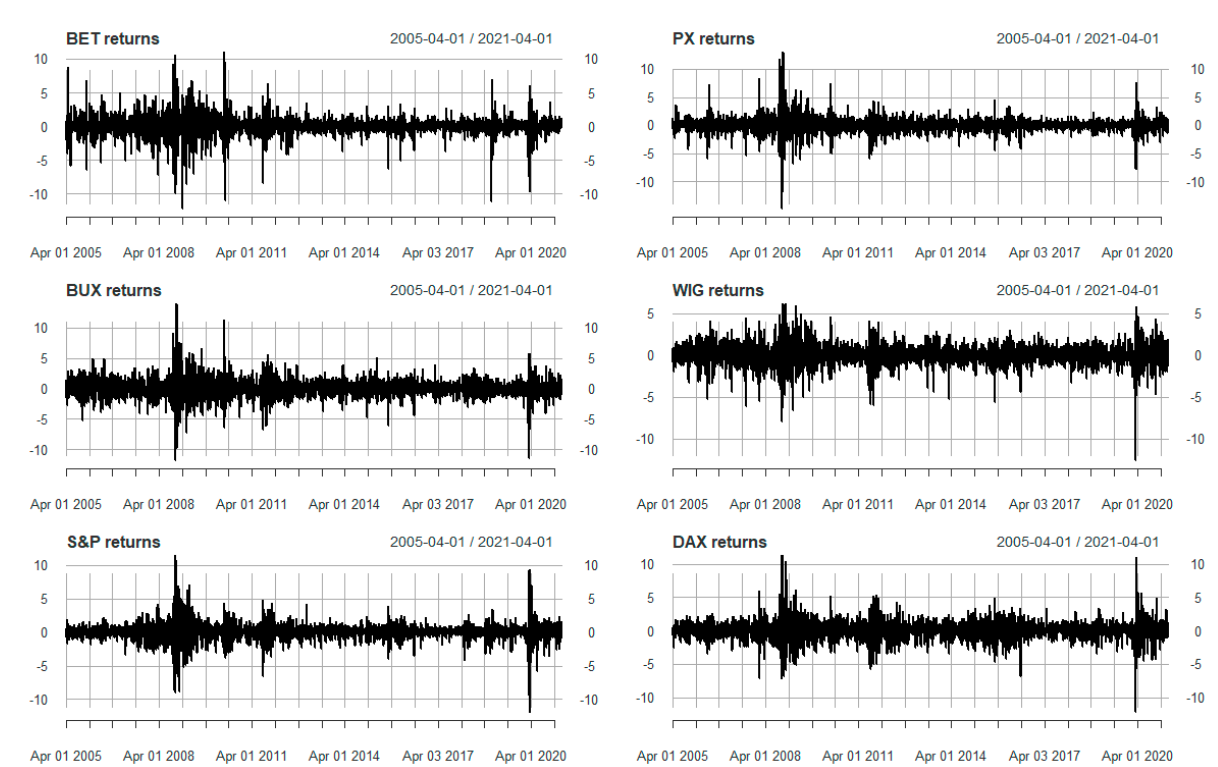
Figure A3. The Daily Returns on the Stock Market Indices.